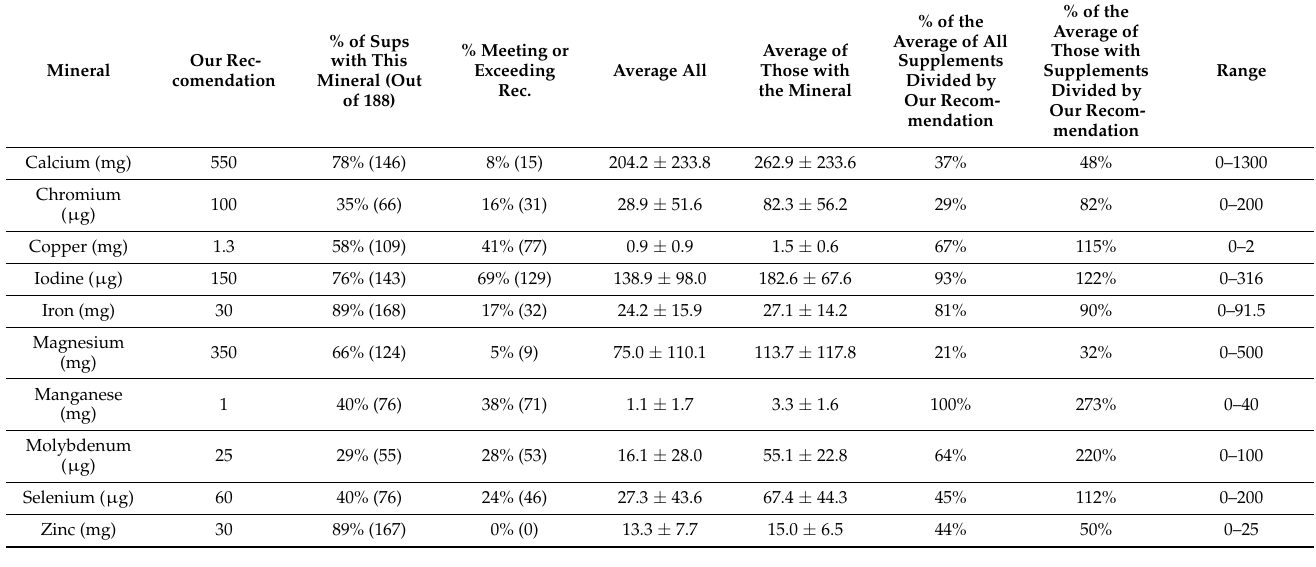
Table 6. Comparison of prenatal supplements on market vs. our recommendations.